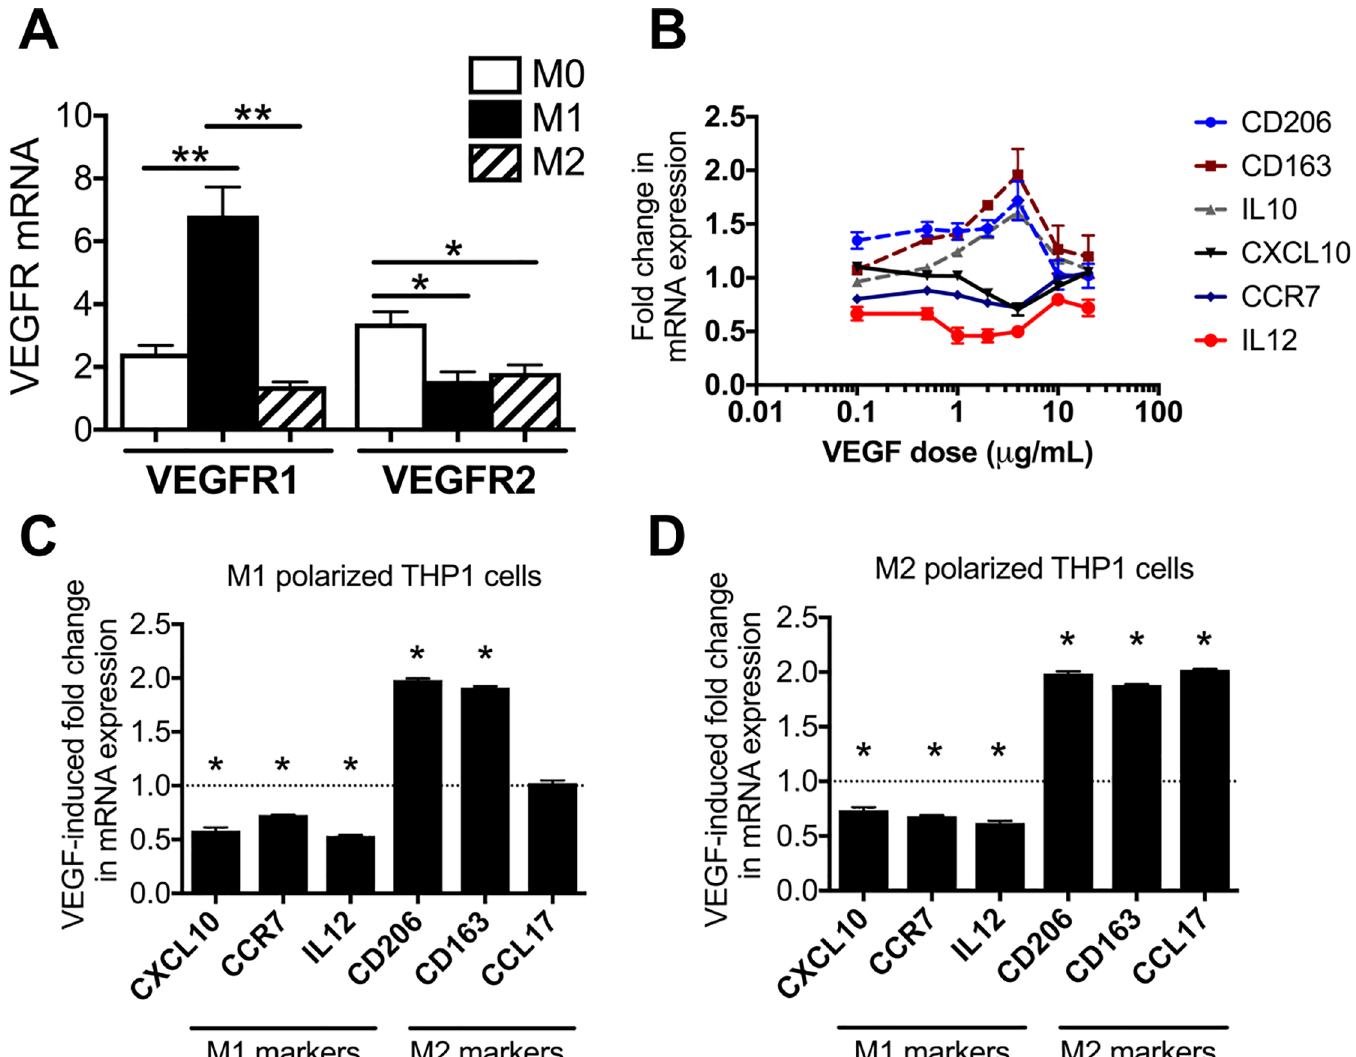
Fig 3. VEGF treatment suppresses M1 markers and induces M2 markers in polarized macrophages. A, qPCR analysis of M0, M1, and M2 cells shows that all three express both VEGF receptors 1 (VEGFR1) and 2 (VEGFR2). Note the highly significant increase in expression of VEGFR1 in M1 cells. B, initial dose-response study showing the effect of increasing concentrations of rhVEGF (0.1–20 μg/mL). VEGF induces an upregulation of M2 markers and downregulation of M1 markers in THP1-derived M1 cells, with highest response seen at 4 μg/mL. C-D, VEGF treatment at 4 μg/mL caused an increase in M2 markers and a decrease in M1 markers in both THP1-derived M1 (C) and M2 (D) macrophages. Graphs represent means ± standard errors; (cid:3) = p < 0.05, (cid:3)(cid:3) = p < 0.01.